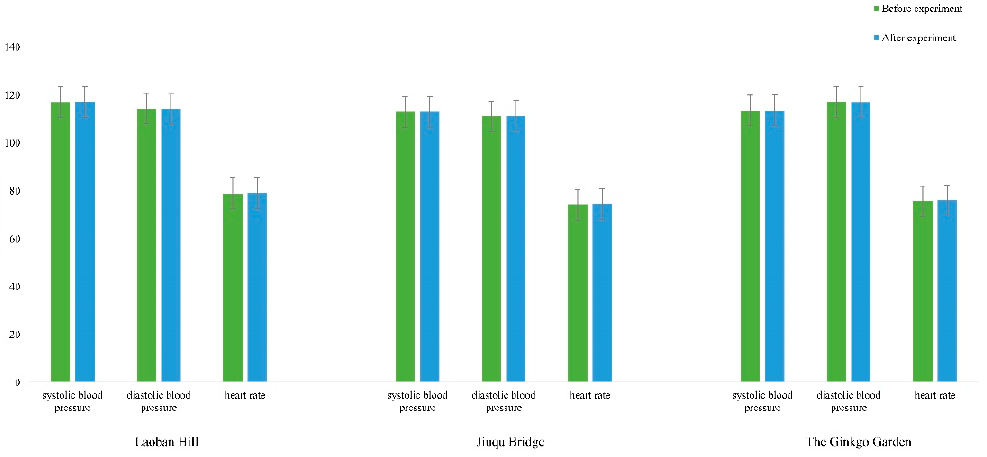
Figure 2. Blood Pressure and Heart Rate.